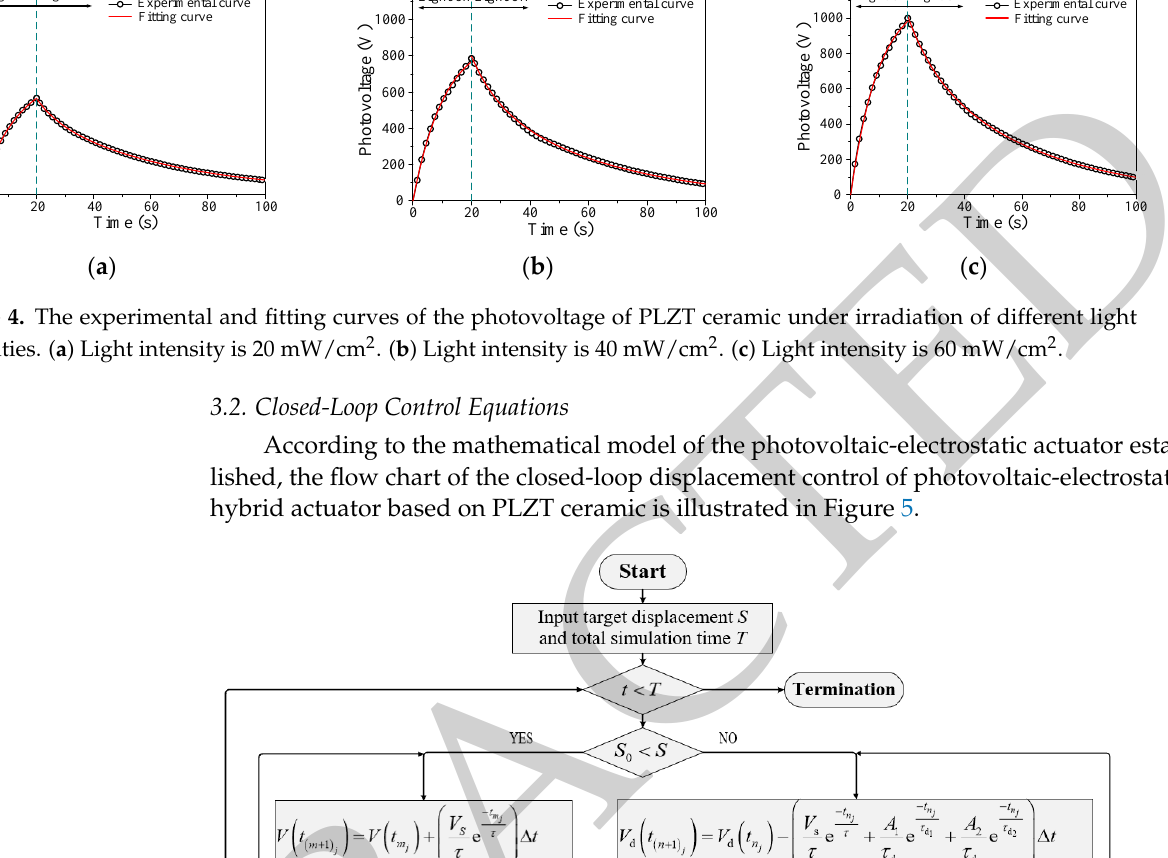
According to the mathematical model of the photovoltaic-electrostatic actuator established, the flow chart of the closed-loop displacement control of photovoltaic-electrostatic hybrid actuator based on PLZT ceramic is illustrated in Figure 5.